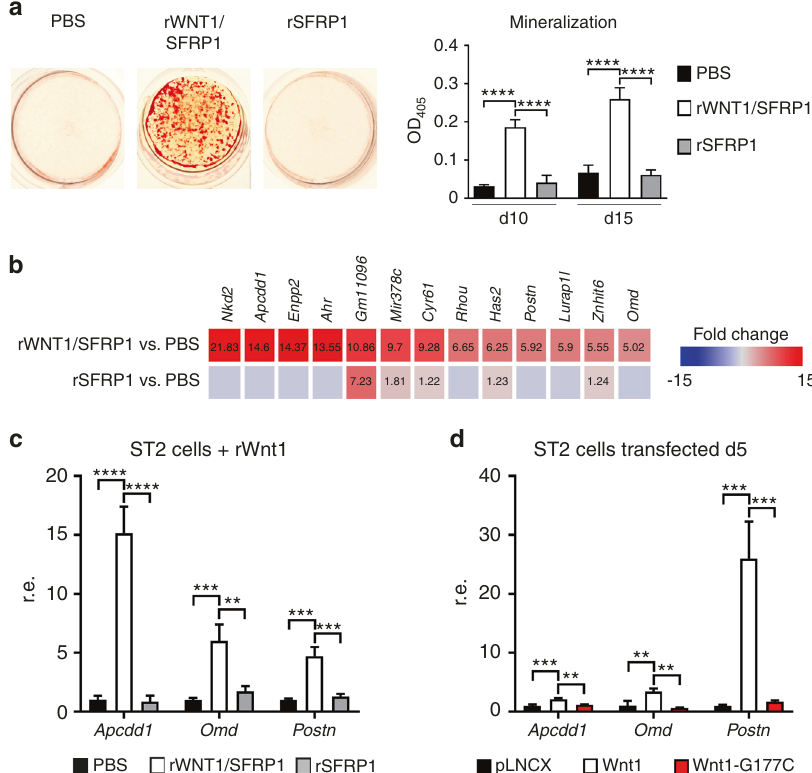
Fig. 7 Intact WNT1 induces a speci fi c transcriptional response indicating canonical Wnt signaling activation. a Representative images of alizarin red staining of ST2 cells continually treated with recombinant murine WNT1/SFRP1 complex, SFRP1 alone or PBS after 15 days of osteogenic differentiation. The quanti fi cation of the mineralization at Day 10 and Day 15 of differentiation is given on the right. Data were analyzed by one-way ANOVA with Tukey ’ s multiple comparison test (**** P < 0.000 1). n = 3 samples per group. b Genome-wide expression analysis of ST2 cells after 6 h of stimulation with the WNT1/SFRP1 complex, SFRP1 alone or PBS. Shown are all genes displaying a more than fi ve-fold induction by the WNT1/SFRP1 complex compared to PBS-treated cells. The numbers in the boxes indicate a positive fold-change. The second line shows the effect of SFRP1 alone. c qRT – PCR-based veri fi cation of the observed induction of Apcdd1, Omd and Postn . d Expression of the same genes in ST2 cells transiently transfected with either empty vector (pLNCX) or with expression plasmids for wild-type ( Wnt1 ) or mutant Wnt1 ( G177C ) 5 days after transfection. Data were analyzed by one-way ANOVA with Tukey ’ s multiple comparison test (** P < 0.01, *** P < 0.001, **** P < 0.000 1). n = 3 samples per group. Error bars indicate standard transition from the modeling to the remodeling phase of bone turnover as well as the onset of age-related bone loss that differs between male and female mice, possibly due to altered hormone and cytokine pro fi les. 37 In contrast, cortical thickness was consistently reduced in male and female Wnt1 G177C/G177C mice of